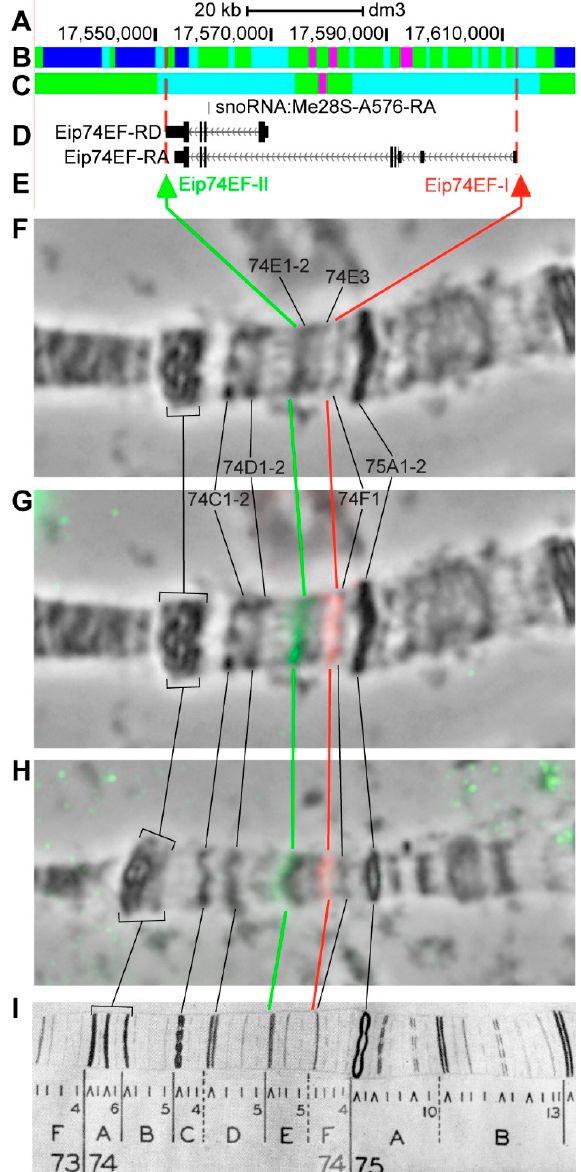
Figure 18. Localization of the Eip74EF gene in the 74E region (the gene is bound by red dotted lines). (A) the scale (kb) and genomic coordinates (bp); (B) the four chromatin-state model [39]; (C) the chromatin condensation level model [32]; (D) genes location (arrow lines show the gene orientation and black bars indicate the location of gene exons); (E) probes location; (F) phase-contrast micrograph of the region; (G) combined FISH signals; (H) combined FISH signals on the stretched chromosome preparation; and, (I) P. Bridges’ chromosome map [57].